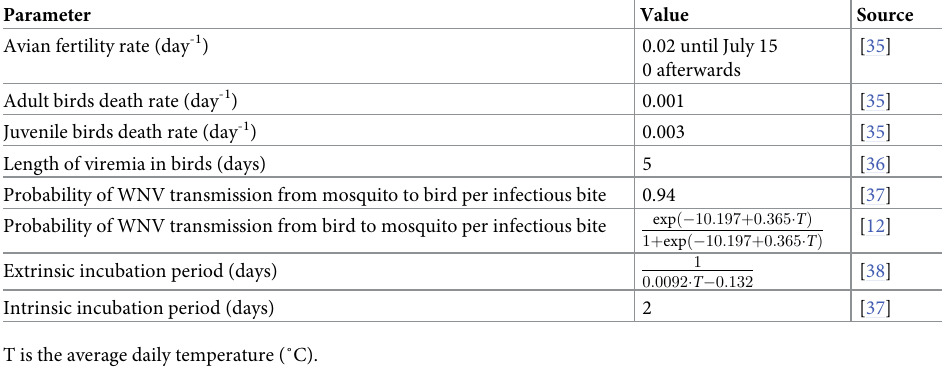
Table 2. Avian parameters for the epidemiological